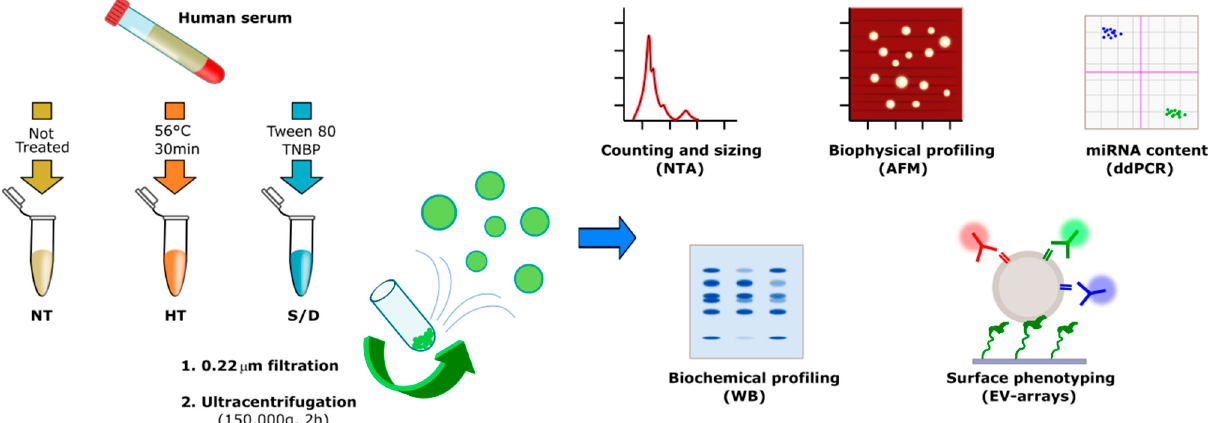
Scheme 1. Workflow describing the sample treatments and Extracellular Vesicle (EV) isolation and characterization. The number of samples analyzed by each technique is reported in Table S1 in the Supplementary Material.